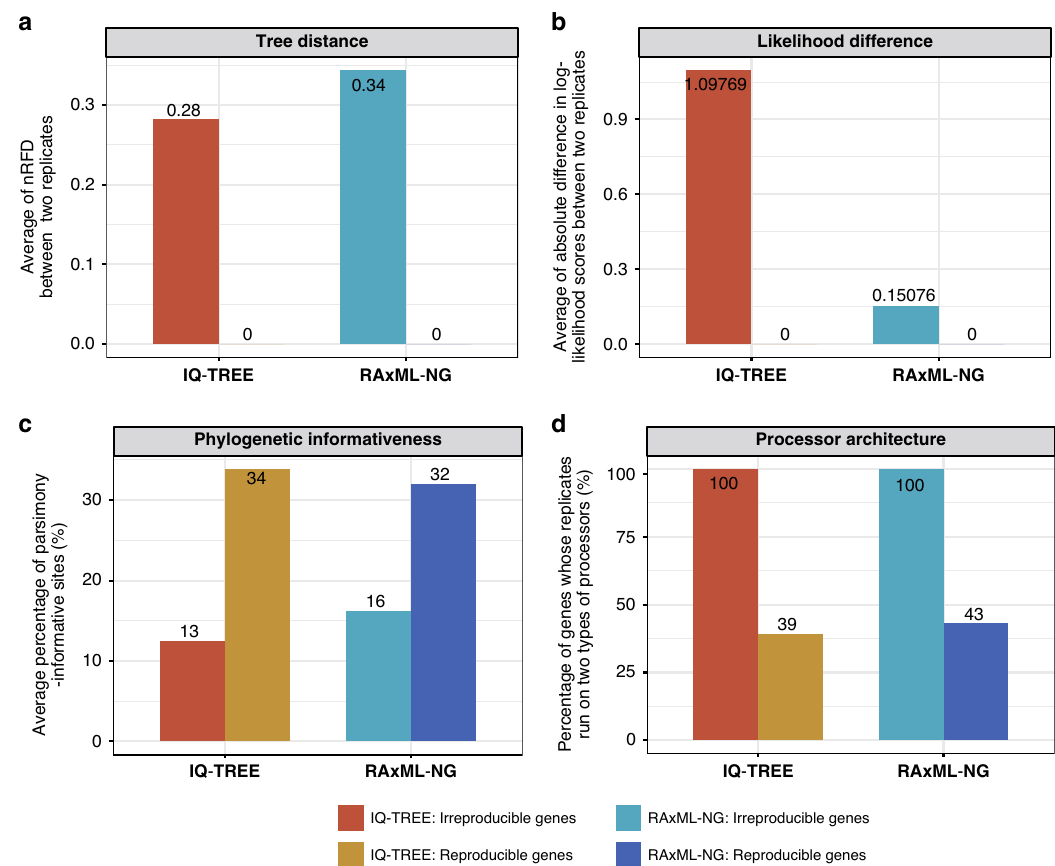
Fig. 3 Key differences between genes that yield irreproducible phylogenies and those that yield reproducible ones. Using IQ-TREE, 3515/19,414 (18.1%) gene alignments from 15 phylogenomic data sets yielded irreproducible phylogenies between two replicates (red bars), while the remaining 15,899 (81.9%) yielded reproducible phylogenies (yellow bars). Using RAxML-NG, 1813 (9.3%) genes yielded irreproducible phylogenies between two replicates (green bars), while 17,601 (90.7%) yielded reproducible phylogenies (blue bars). For the sets of reproducible and irreproducible genes in IQ-TREE and RAxML-NG analyses, a the normalized Robinson – Foulds tree distance (nRFD) between the gene trees inferred from the Run1 and Run2 replicates, b the absolute difference in log-likelihood values between the Run1 and Run2 replicates, c the percentage of a number of parsimony-informative sites in gene alignment, and d the percentage of Run1 and Run2 replicates executed on two separate 2-CPU nodes with different processor architectures (ML programs can automatically detect the kernel instructions on current processor architecture to best exploit the capabilities of CPU processor). a , b The degree to which the Run1 and Run2 trees of genes that yield irreproducible phylogenies differ in topology ( a ) and likelihood value ( b ). Irreproducible genes have a much lower average percentage of parsimony-informative sites ( c ) and run much more frequently on two different processors ( d ) than reproducible genes. Detailed values are given in Supplementary Data